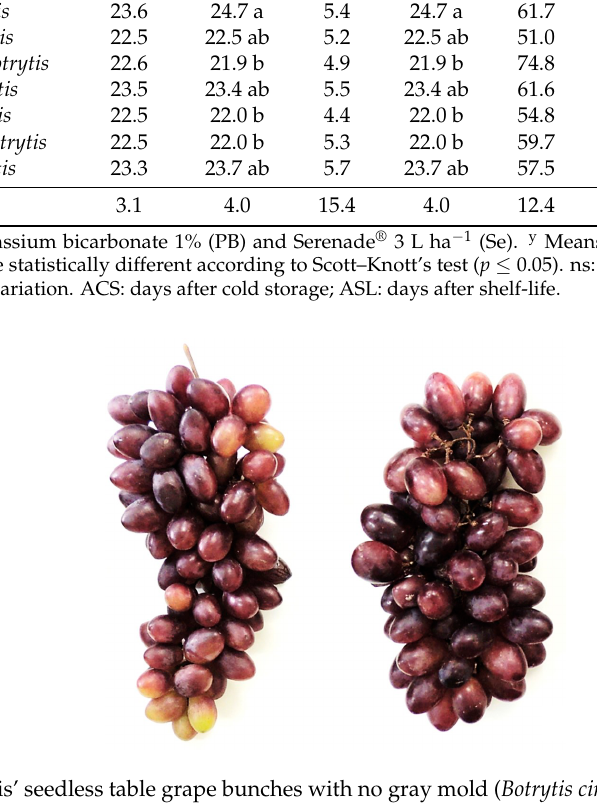
Figure 2. ‘BRS Isis’ seedless table grape bunches with no gray mold ( Botrytis cinerea ) symptoms 50 days after cold storage and five days of shelf-life.